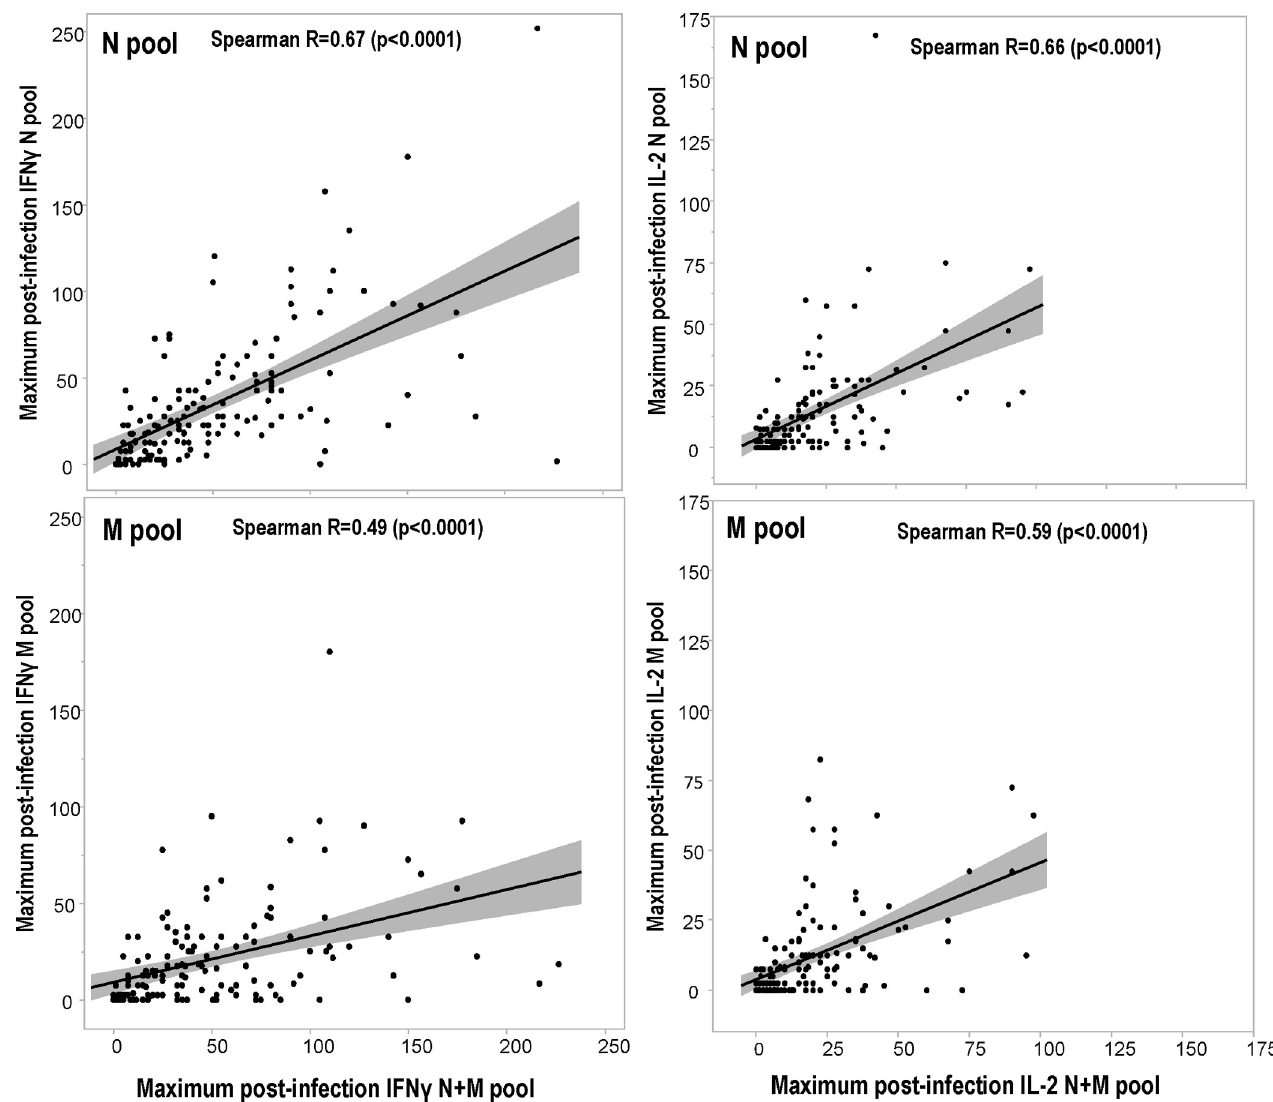
Fig 3. Correlations of the magnitude of IFN- γ and IL2 responses post-infection to the N and M pools with IFN- γ and IL2 responses to the N+M pool. The maximum IFN- γ and IL2 responses post-infection to the N and M pools were compared to those to the mixture of N+M pool in matched participants by Spearman Rank